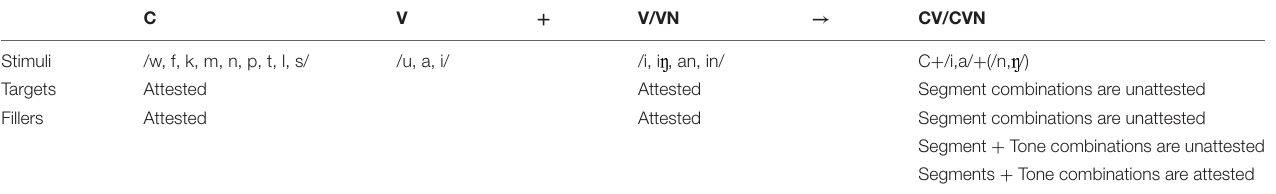
TABLE 3 | Stimuli attestedness in